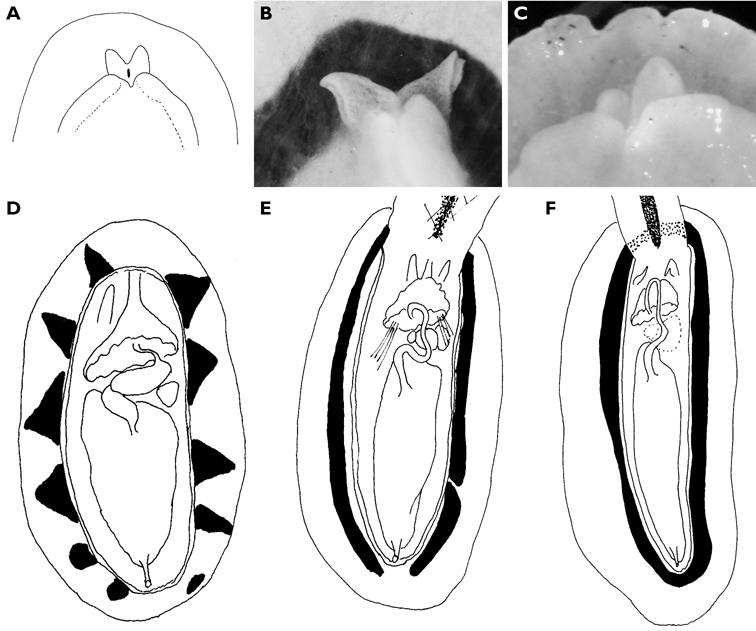
Phyllidia koehleri
A ventral view of propodium, head, and oral tentacles of 11 mm pres. specimen. B ventral view of propodium, head, and oral tentacles of 14 mm pres. specimen C ventral view of propodium, head, and oral tentacles of 17 mm pres. specimen D digestive anatomy of 11 mm pres. specimen E digestive anatomy of 14 mm pres. specimen F digestive anatomy of 17 mm pres. specimen.